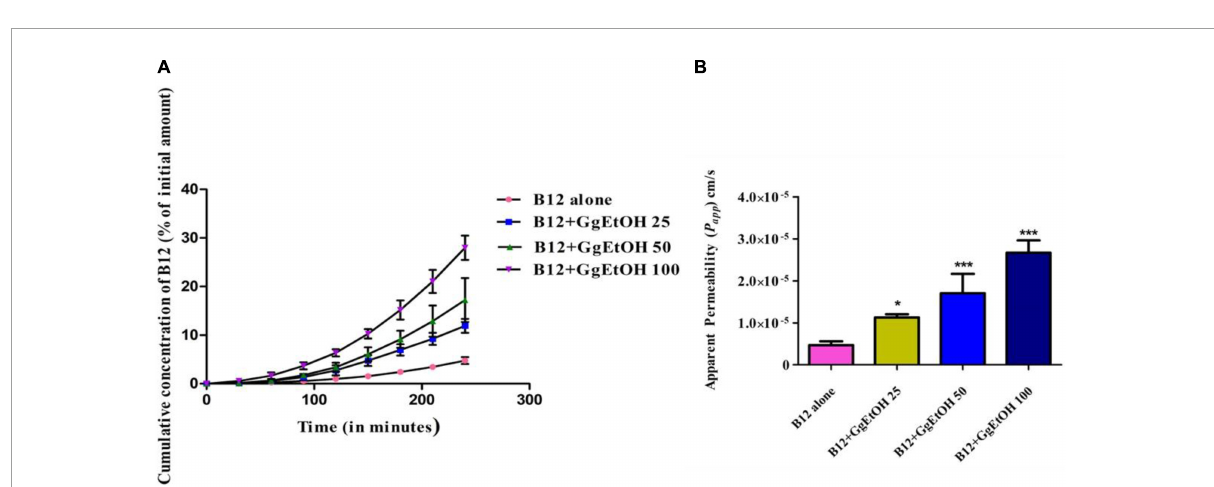
FIGURE2 (A) Cumulative amount of B12 transport with time (expressed as % of initial concentration) across Caco-2 monolayers. Each point represents mean ± SD ( n = 4). (B) Effect of GgEtOH on permeability enhancement of Vitamin B12 in in vitro Caco-2 assay. B12 alone—Caco 2 monolayers treated with 200 µ g/ml Cyanocobalamin only, B12+GgEtOH 25, B12+GgEtOH 50, B12+GgEtOH 100—Caco 2 monolayers treated with combination of Cyanocobalamin 200 µ g/ml and GgEtOH at concentrations 25, 50, and 100 µ g/ml, respectively. Data presented as mean ± SD ( n = 4) * p < 0.05, ** p < 0.01, *** p < 0.001 with respect to B12